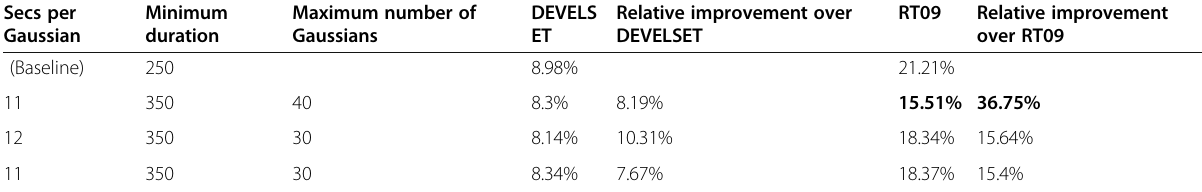
Table 7 SER for the DEVELSET and the RT09 set when using the model selection method and a single mfcc stream